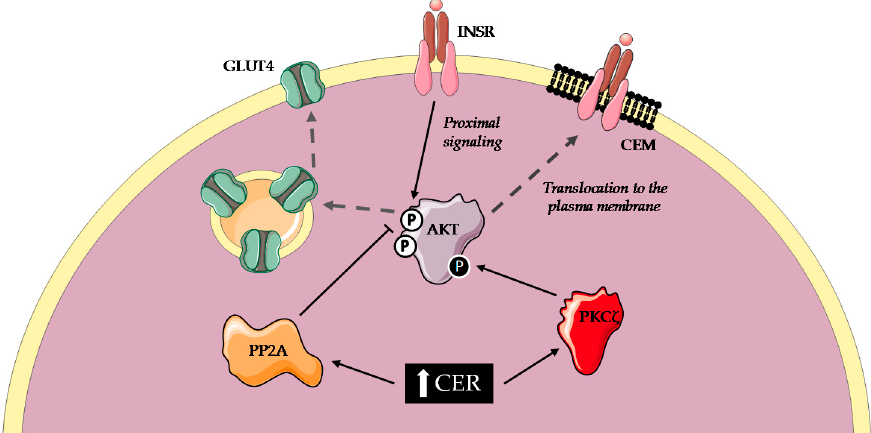
Figure 2. Molecular mechanisms of ceramides-mediated insulin resistance. Short term accumulation of ceramides leads to insulin resistance in various cell types. Ceramides activate PKC ζ that phosphorylates Akt and prevents translocation to the plasma membrane. They also activate PP2A which dephosphorylates Akt, in turn blunting Akt-mediated activation of GLUT4 translocation to the plasma membrane. AKT Protein kinase B; CEM Caveolin enriched micordomains; CER Ceramides; GLUT4 Glucose transporter type-4; INSR Insulin receptor; PKC ζ Protein kinase C ζ ; PP2A Protein phosphatase